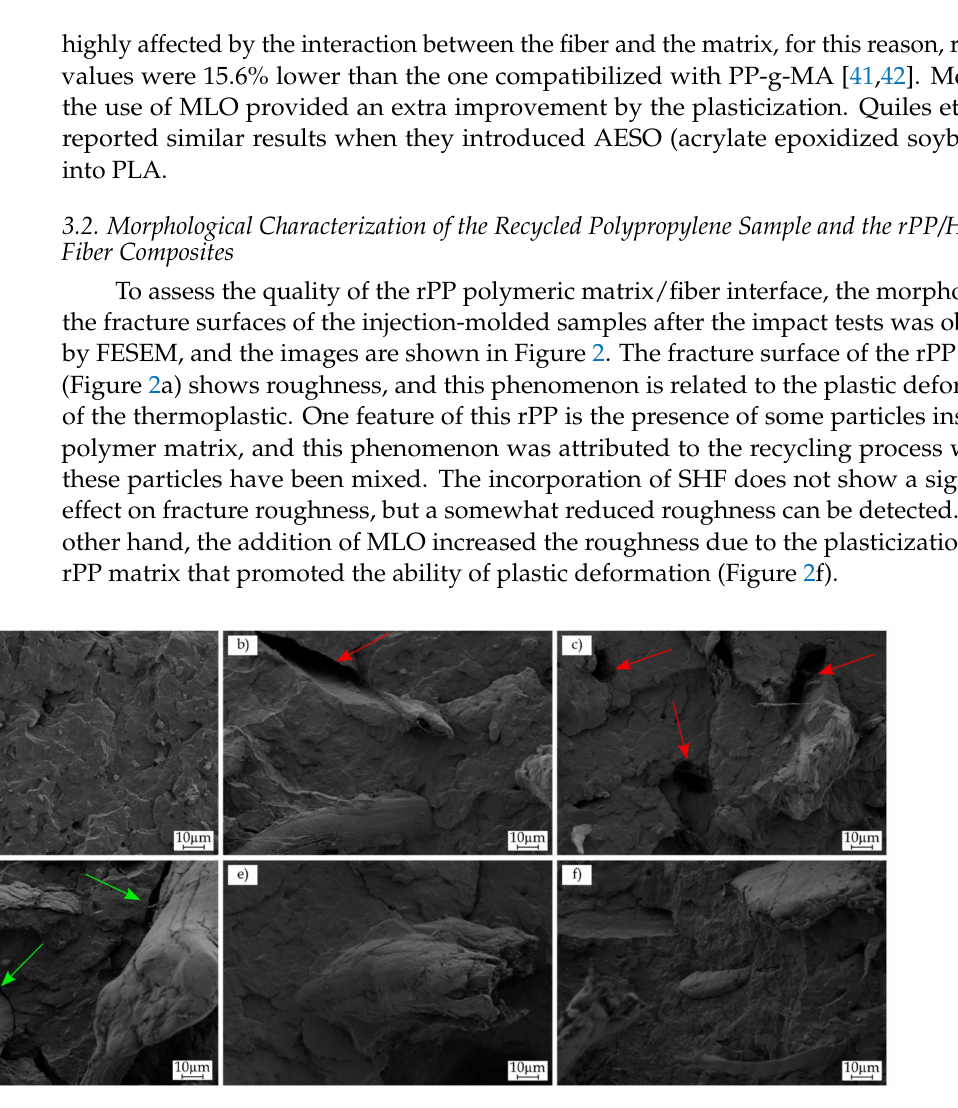
Figure 2. Field-emission scanning electron microscopy (FESEM) images of the fracture surfaces of the injection-molded rPP/hemp composite parts: ( a ) rPP; ( b ) rPP-H10-C; ( c ) rPP-H20-C; ( d ) rPP-H30; ( e ) rPP-H30-C; and ( f ) rPP-H30-M. Images were taken at 500 ×